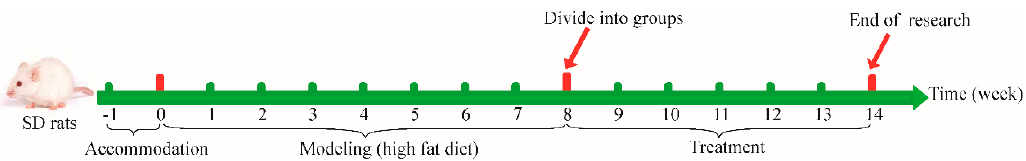
Figure 8. A schematic diagram of the experimental treatment schedule. All rats except normal control (NC) rats were raised on an HFD for 8 weeks. Obese rats (body weight >20% higher than in NC rats) were then divided into three groups: HFD (high-fat diet), HFD + SIM (high-fat diet with simvastatin), and HFD + POP (high-fat diet with Polygonatum odoratum polysaccharides). All rats were gavage-dosed once per day for six consecutive weeks (weeks 8–14).